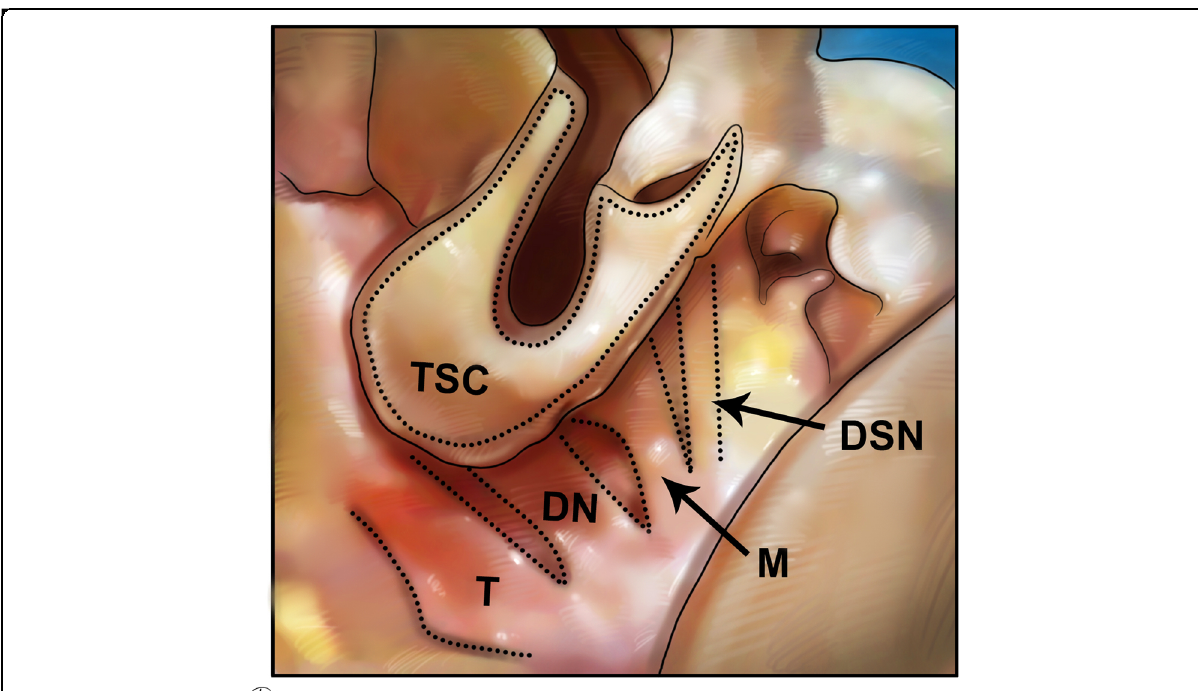
Fig. 13 Tela subcutanea cutis (TSC), dilator naris (DN), mytriformis (M), and depressor septi nasalis (DSN) muscles can be seen in this schematic figure of the nasal area